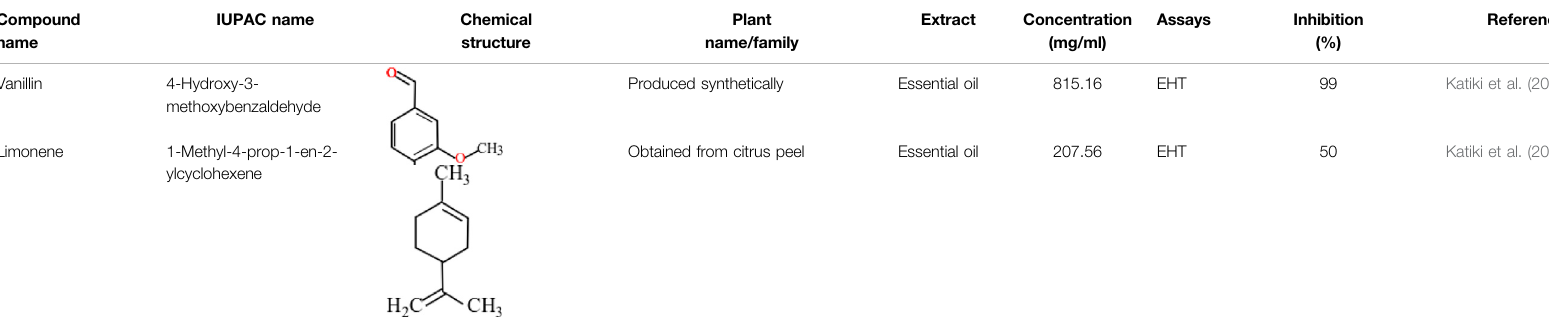
TABLE 3 | ( Continued ) Plant compounds ef fi cacy against H. contortus